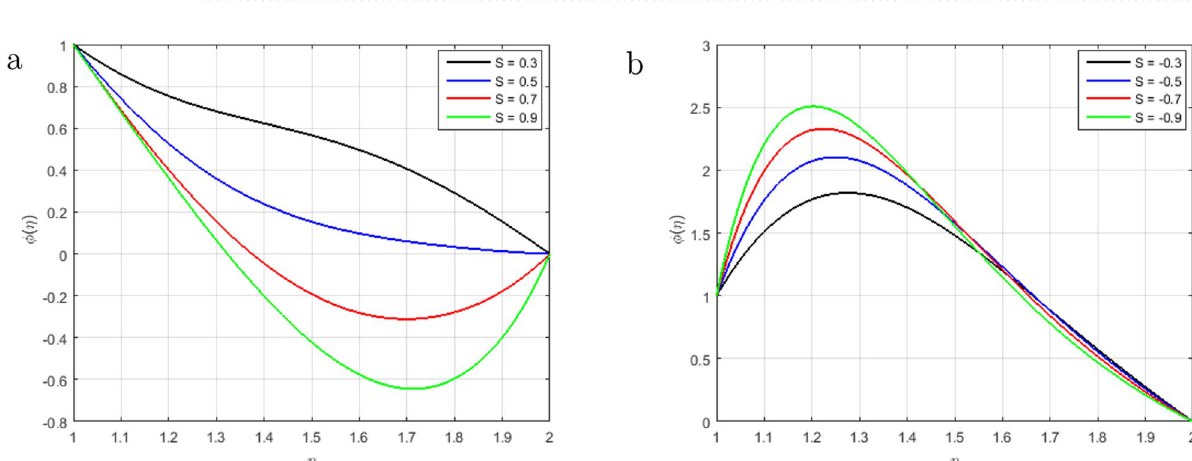
Figure 7. Influence of θ(η) for S > 0 , S < 0 and fixed values of Re m = 2.5, M = 0.5, Pr = 3.2, Hs = 1.2, C 1 = 0.4, Sc = 1.4, Sr = 1.5 .